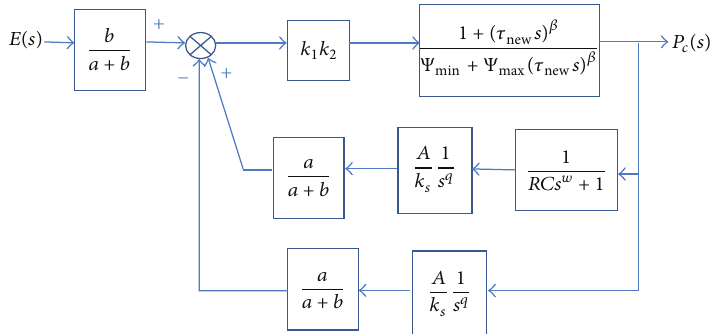
Figure 7: A simplified block diagram for fractional order PI controller.